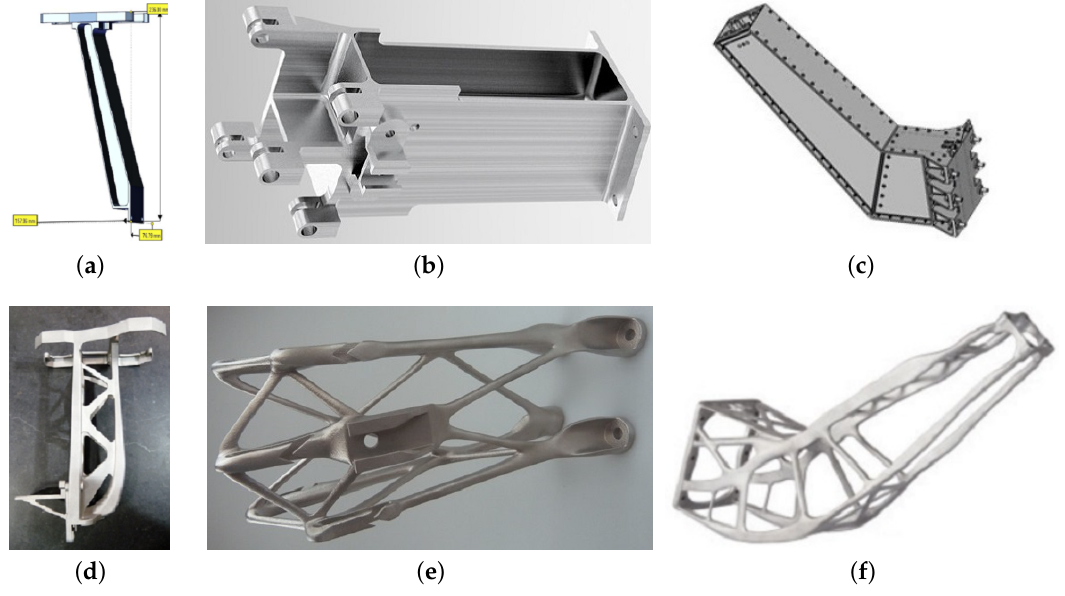
Figure 10. AM optimized structural brackets [95,98]: ( a , d ), ( b , e ) and ( c , f ) examples of optimized brackets from their conventional design to their AM